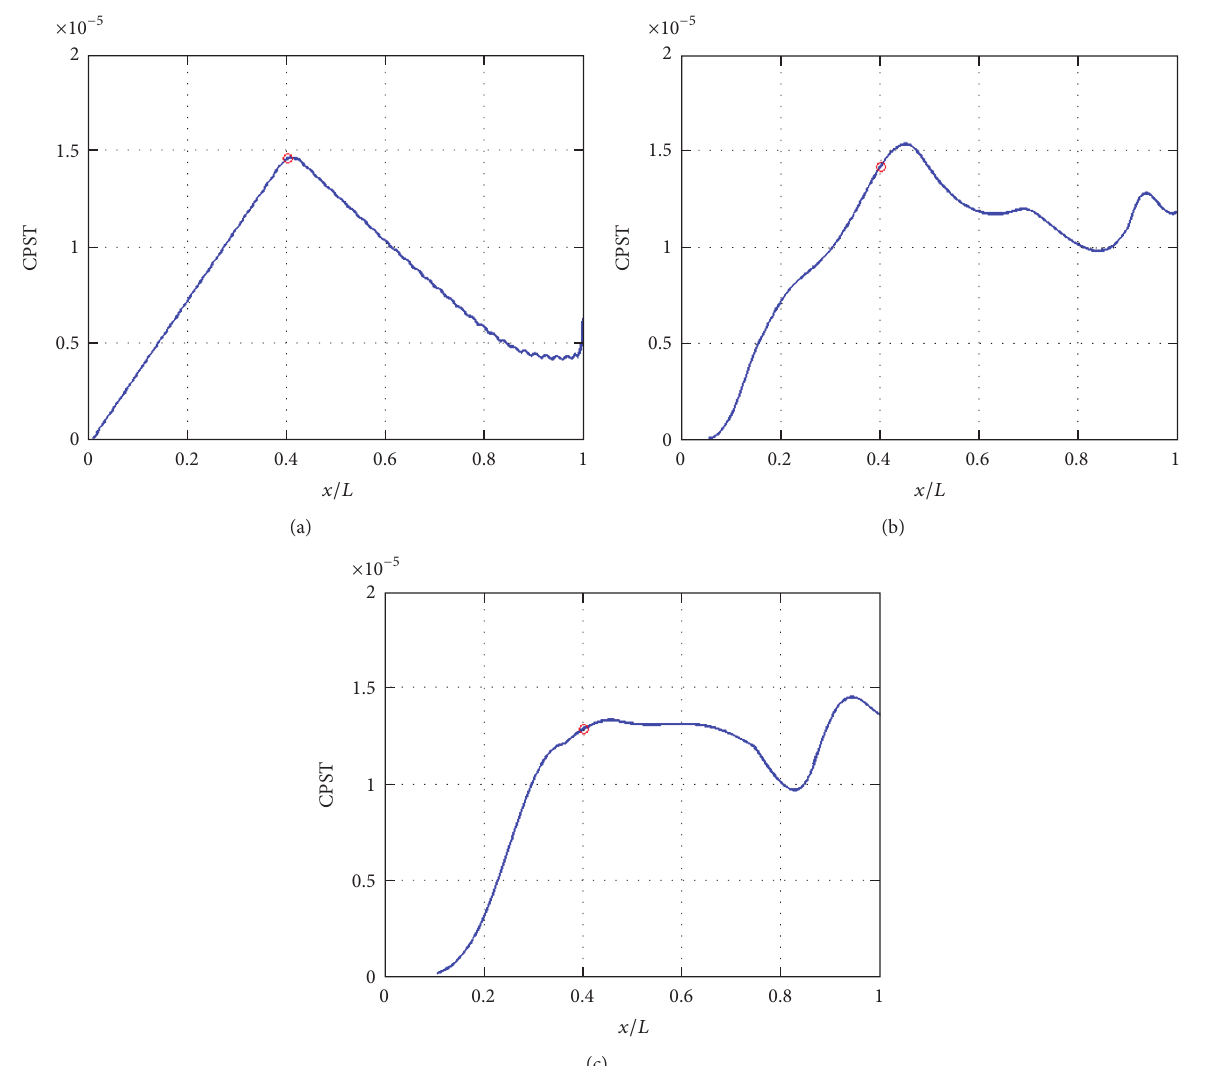
Figure 26: CPST results of different mass velocity with damaged level is 10%, mass is 200 Kg, and sensor location is 𝐿 𝑠 = 0.5 : (a) mass velocity is V = 0.5 m/s, (b) mass velocity is V = 5 m/s, and (c) mass velocity is V = 10